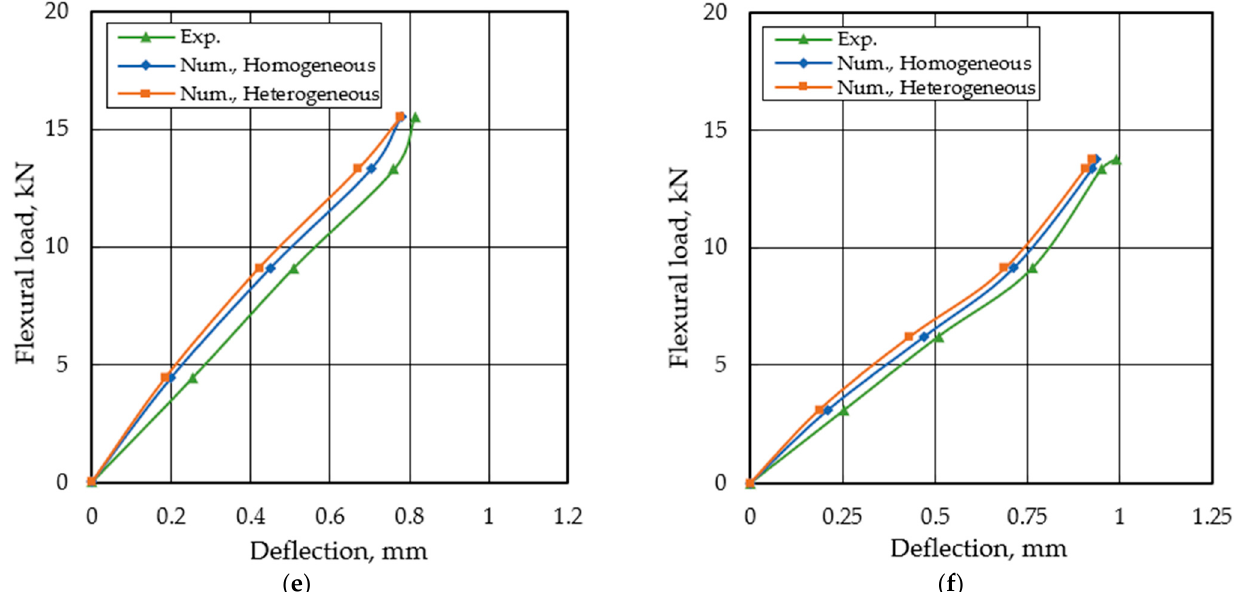
Figure 11. Flexural load—deflection relationships of all the concrete beam models with different rubber ratios: ( a ) Rubber ratio 0%, ( b ) rubber ratio 20%, ( c ) rubber ratio 40%, ( d ) rubber ratio 60%, ( e ) rubber ratio 80%, ( f ) rubber ratio 100%.